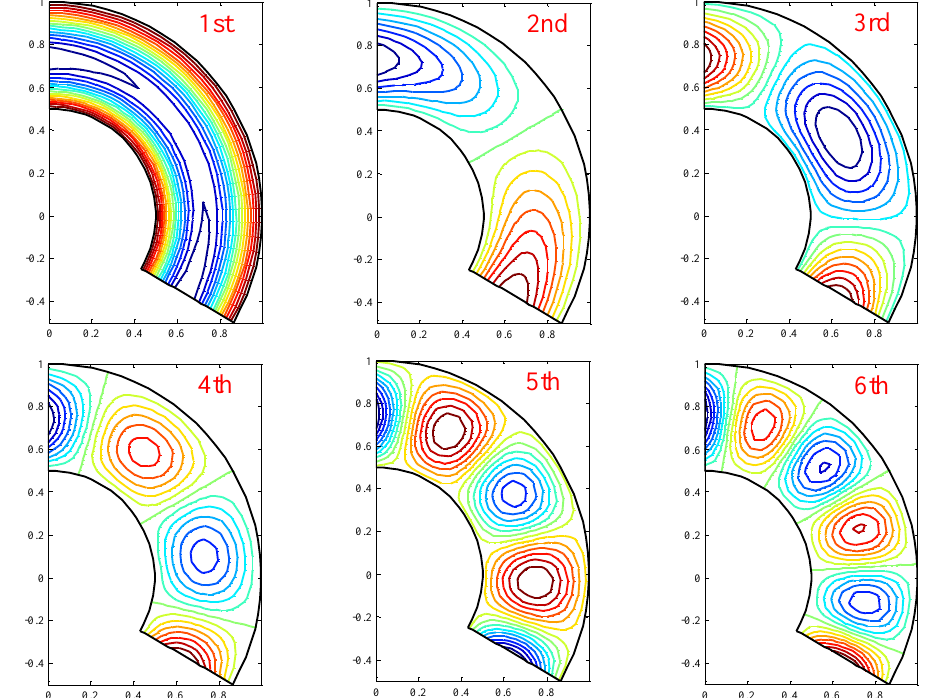
Figure 5: The lowest six mode shapes for a [0 ∘ /90 ∘ /90 ∘ /0 ∘ ] laminated annular sector plate with CFCF boundary conditions( E 1 / E 2 =15, a / b =0.5, h / b =0.1, ϕ =2 π /3)